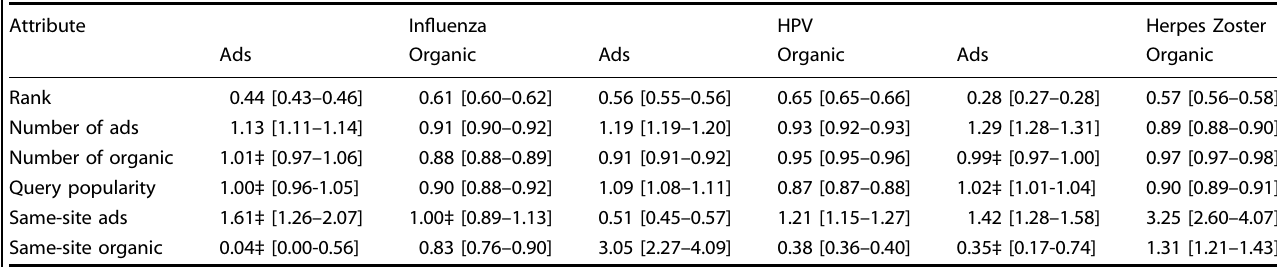
Table 5. Logistic regression model of clicks on ads and organic links for vaccination queries.